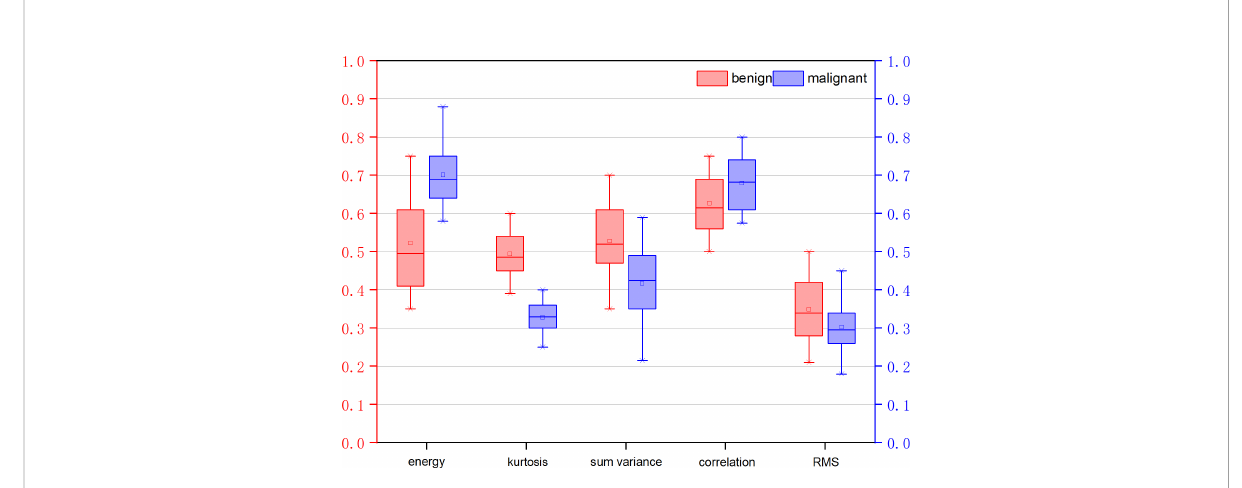
FIGURE 1 Normalized feature value of features selected from the feature map direct energy attenuation diagram